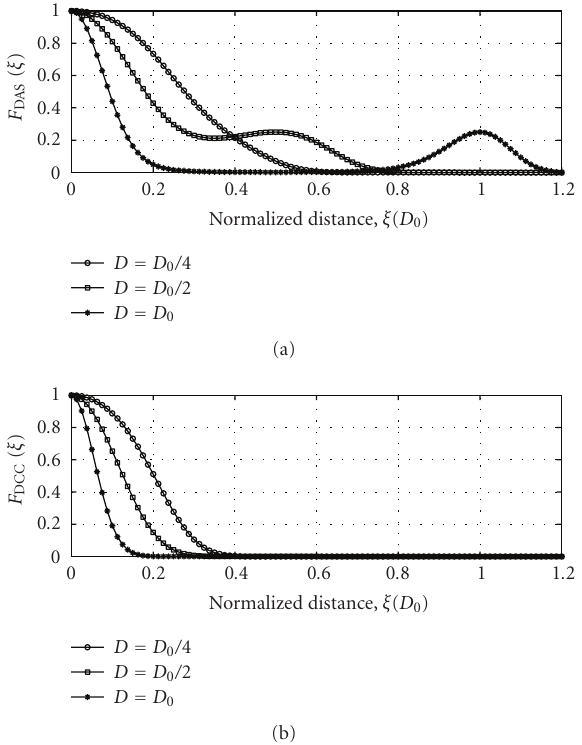
Figure 1: 1D profile response versus lateral normalized distance ξ . (a) Delay-and-sum algorithm (2), (b) Dual cross-correlated back projection algorithm (4). Normalized parameter values. ρ = 0 . 025 and ε = 6 . 25 for D = D 0